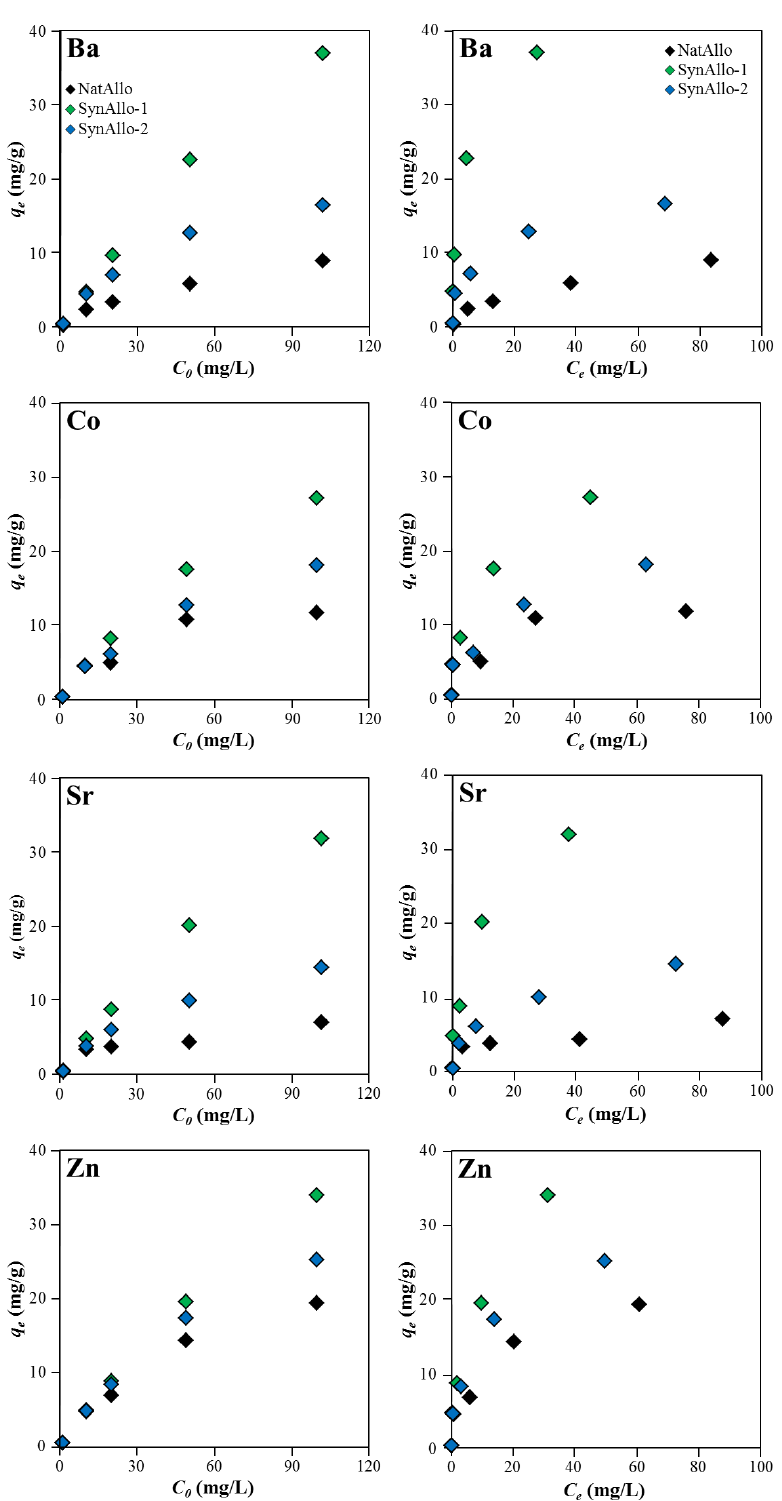
Figure 6. Adsorption behavior of aqueous Ba, Co, Sr, and Zn by natural and synthetic allophanes as a function of metal ion concentration. ( left panel ) Effect of initial metal ion concentration. ( right panel ) Adsorption isotherms at pH 8.5 and 25 °C.